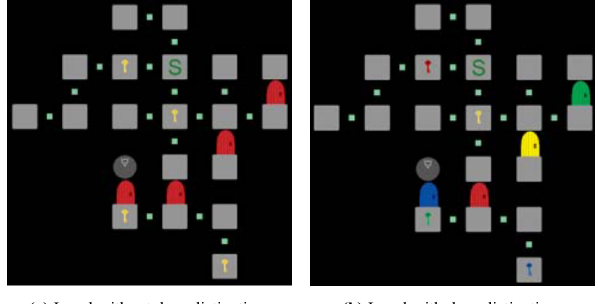
Figure 6. Examples of dungeon sketches generated by Pereira et al. (2018).